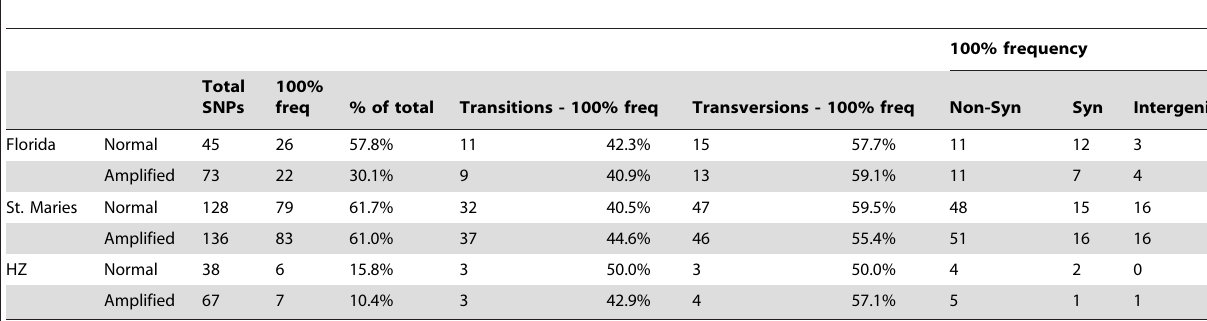
Table 3. Single nucleotide polymorphism statistics (freq – frequency, Syn –